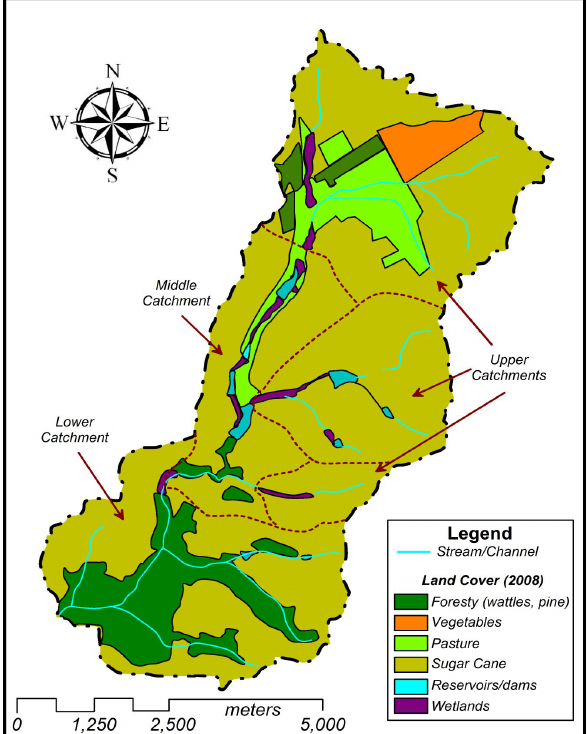
Fig. 2. Map showing distribution of observed land-use types within the Mkabela Catchment (modified from Lorentz et al.,